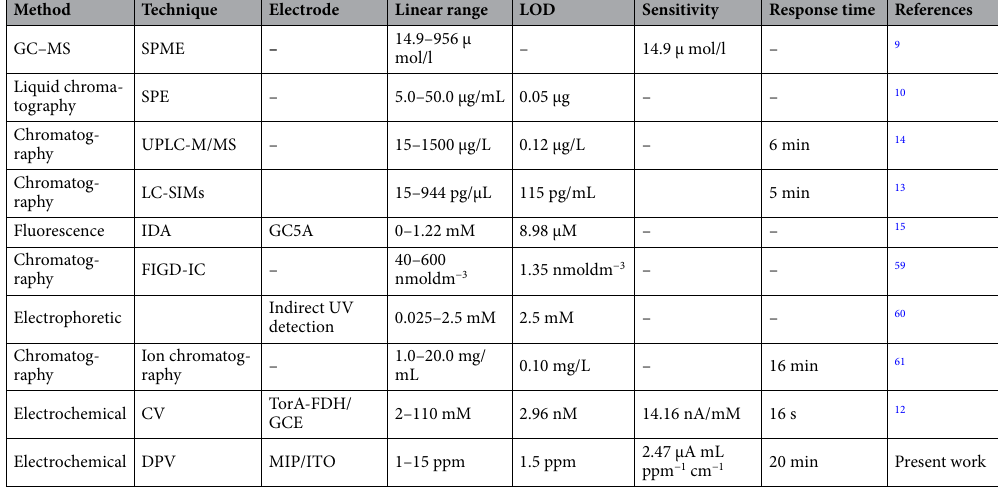
Table 1. Comparison of biosensing platform of MIP/ITO electrode with previously reported techniques towards TMAO detection. FDH: format dehydrogenase; FIGD-IC: flow injection-ion chromatographic technique; GC–MS: gas chromatography-mass spectrometry; GC5A: guanidinium-modified calix [5] arene; GCE: glassy carbon electrode; IDA: indicator displacement assay; LC-SIMs: liquid chromatography-selective ion monitoring; SPE: solid phase extraction; SPME: solid phase microextraction; TorA: TMAO reductase; and